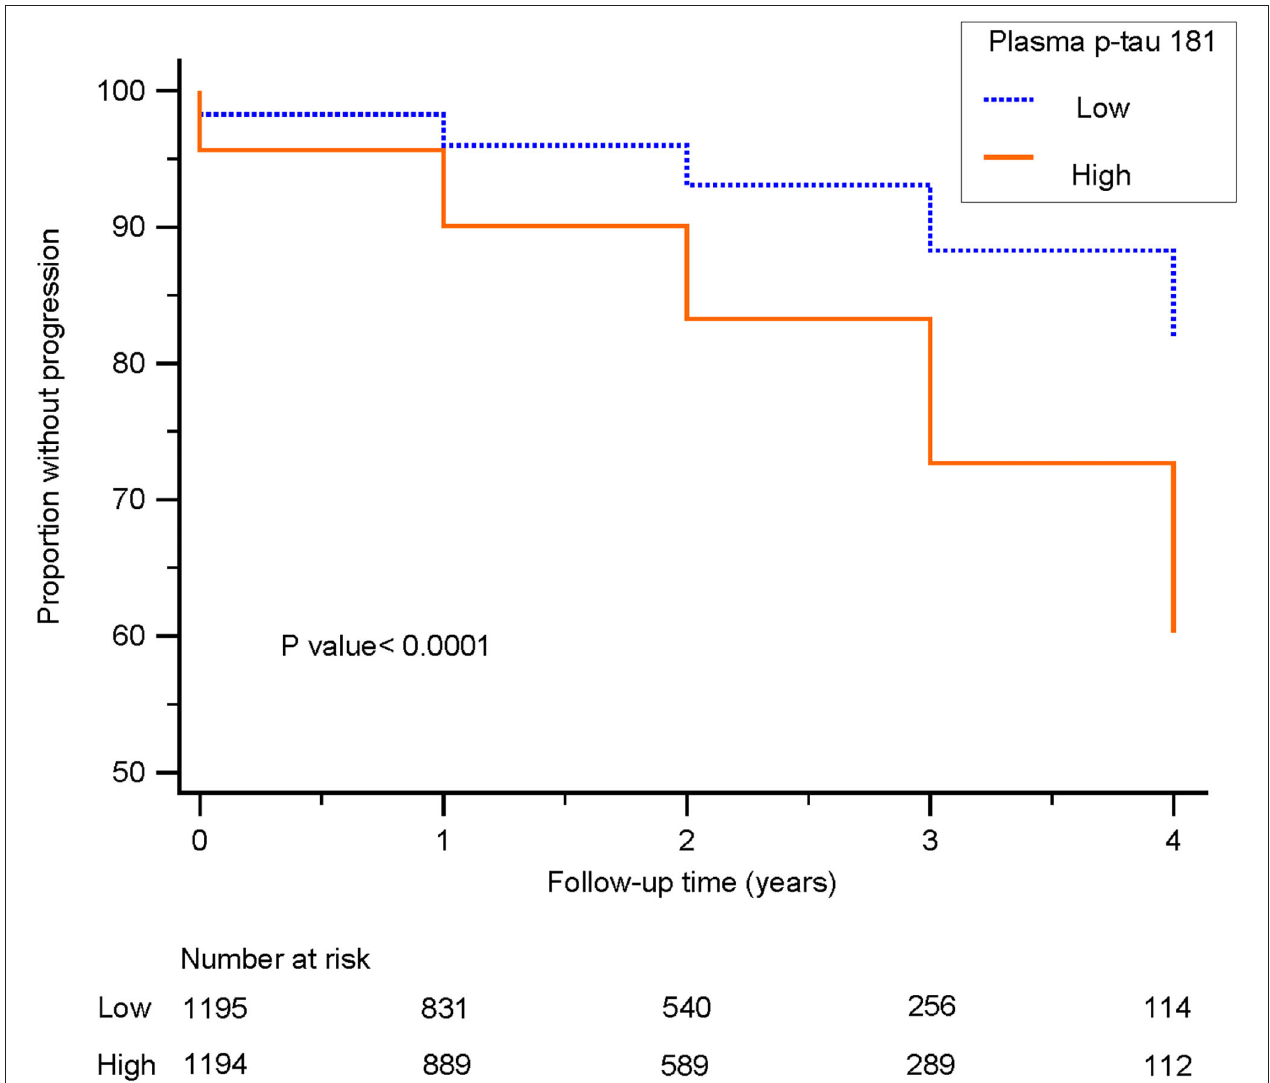
FIGURE 5 | Survival curves for patients with low and high levels of plasma p-tau 181 are shown. Survival curves delineate subjects with cognitively unimpaired or mild cognitive impairment progressing to dementia. Blue line: low level, patients with plasma p-tau 181 levels < 14.981 pg/ml; orange line: high level, patients with plasma p-tau 181 levels higher than 14.982